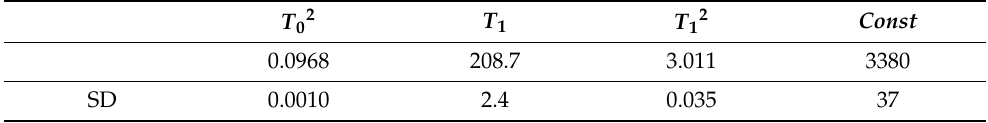
Table 6. The coefficients for Equation (15) with excluded powers of temperatures T 0 and T 1 .